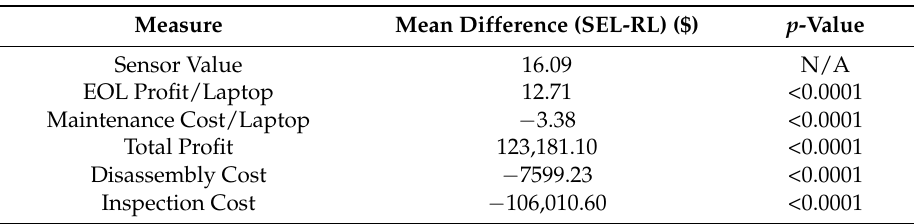
Table 11. Pairwise t -test results for mean difference.